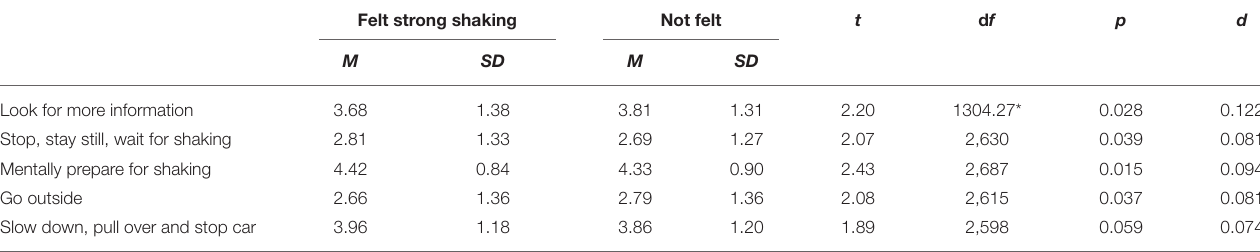
TABLE 1 | Results of independent samples t -tests comparing mean intentions scores for a range of actions between those who have and have not felt strong